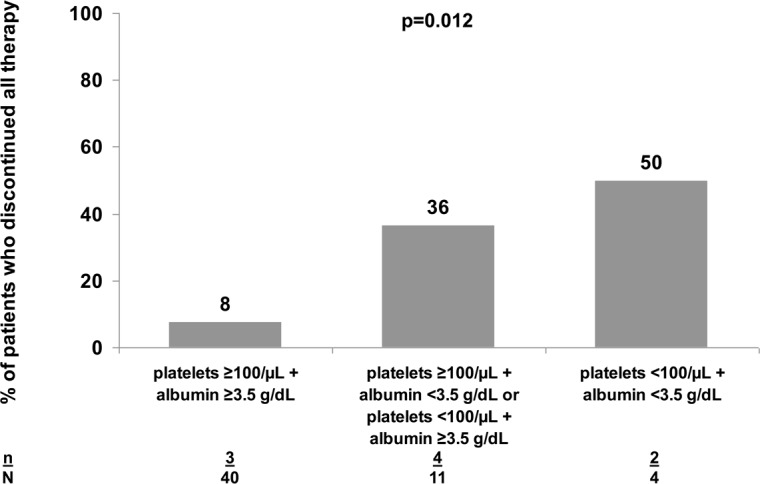
Rate of discontinuations due to adverse events.Proportion of patients who permanently discontinued all therapy due to adverse events after stratifying for baseline platelet count and albumin concentration. Data was available in 46 patients.